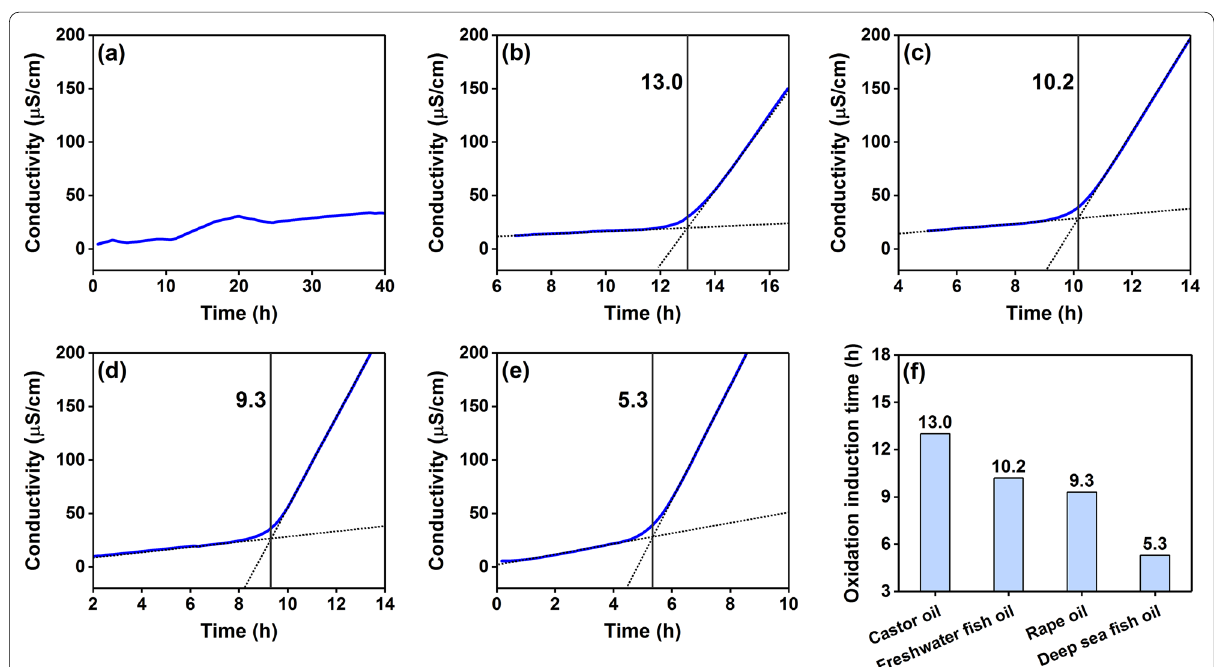
Fig. 3 Conductivity–time curves of synthetic oil ( a ), castor oil ( b ), freshwater fish oil ( c ), rape oil ( d ), deep sea fish oil ( e ), and the oxidation induction time of the natural oils (f), under accelerated oxidation conditions (100 °C, 10 L/h air)